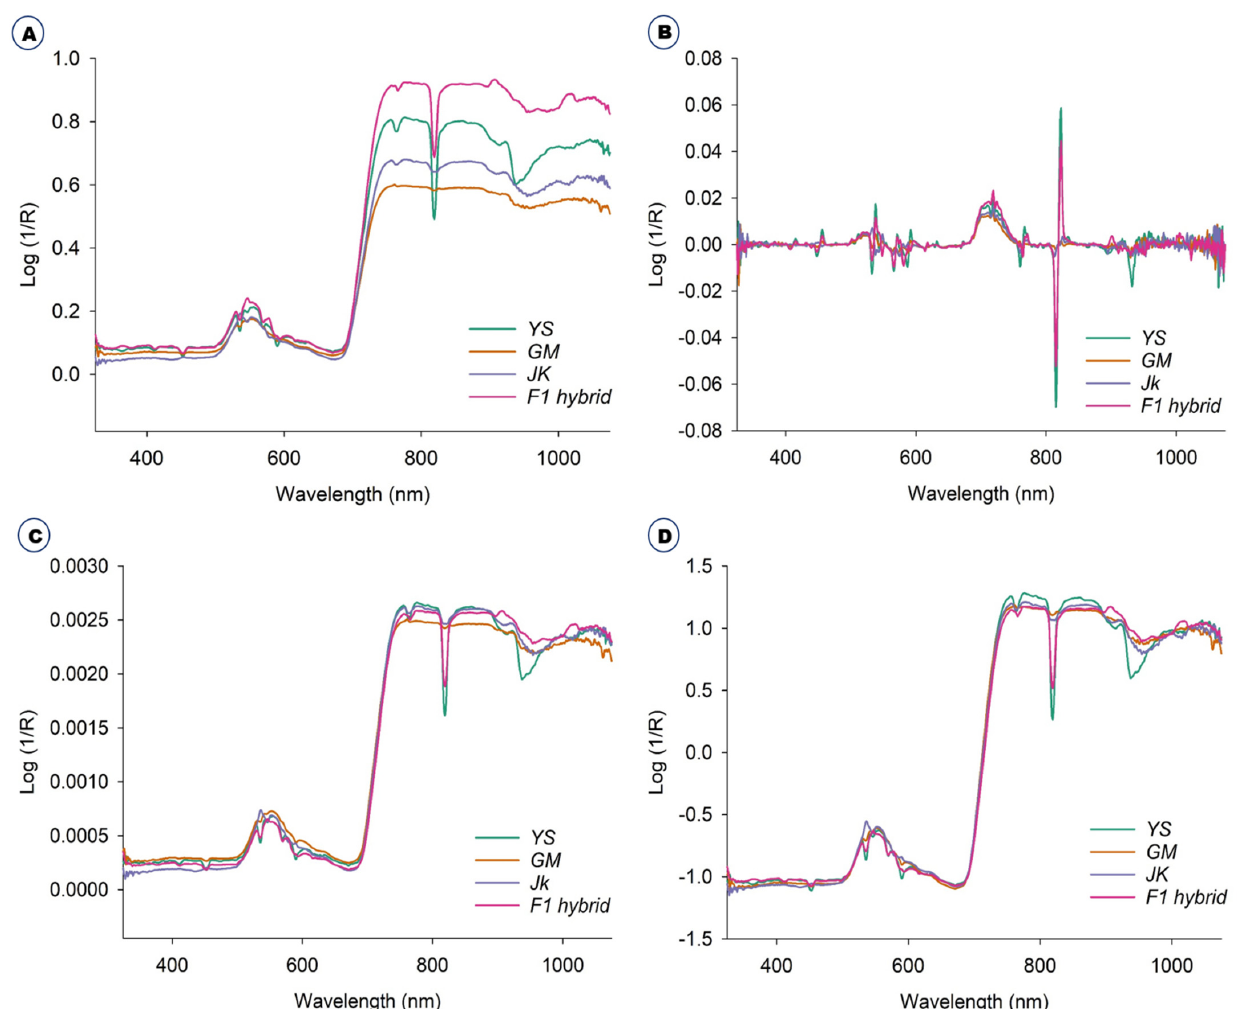
Figure 1. Average spectra obtained from all the plants. ( A ) Raw spectra. ( B ) Savitzky-Golay. ( C ) Normalization. ( D ) Standard Normal Variate.